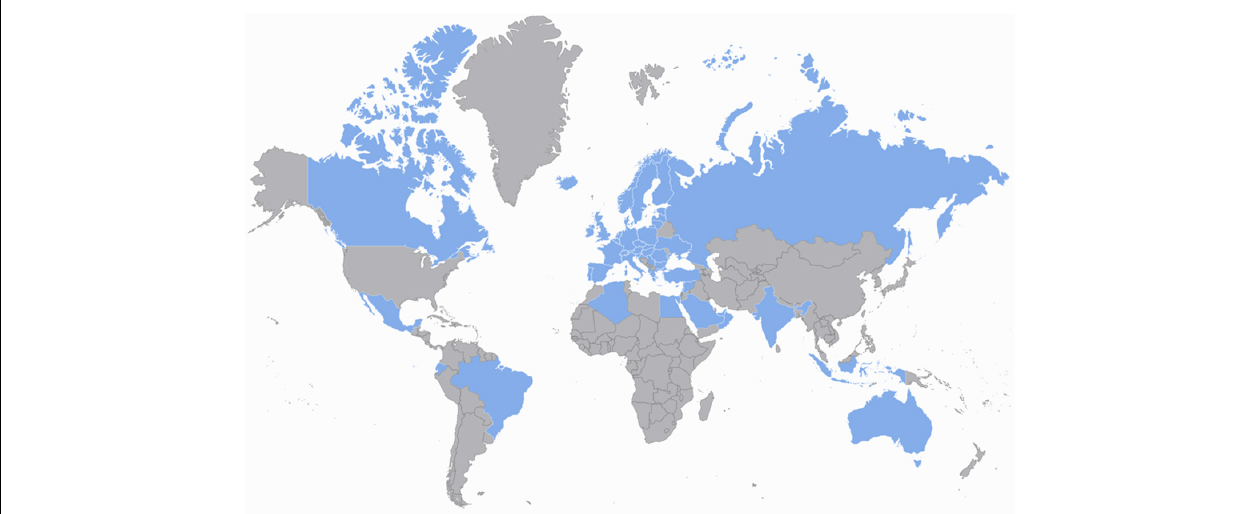
FIGURE 1 | World map showing responding countries (in dark blue): Albania, Algeria, Australia, Austria, Belgium, Brazil, Bulgaria, Canada, Croatia, Cyprus, Czechia, Denmark, Ecuador, Egypt, Estonia, Finland, France, Germany, Greece, Hungary, Iceland, India, Indonesia, Ireland, Israel, Italy, Latvia, Lebanon, Lithuania,